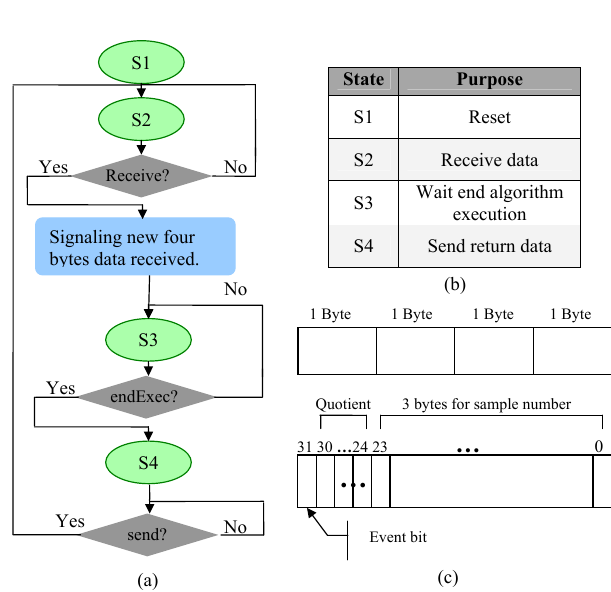
Fig. 5. Data flow diagram dust devils detector.